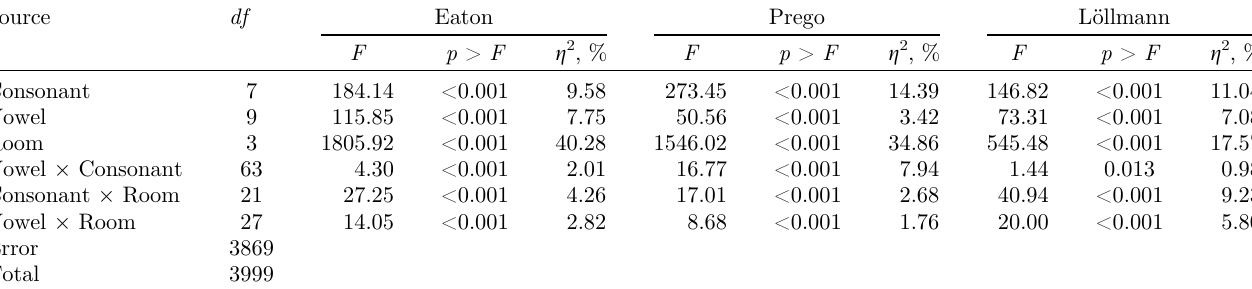
Table 3. CVC set of logatomes: ANOVA tables for the three algorithms. Source